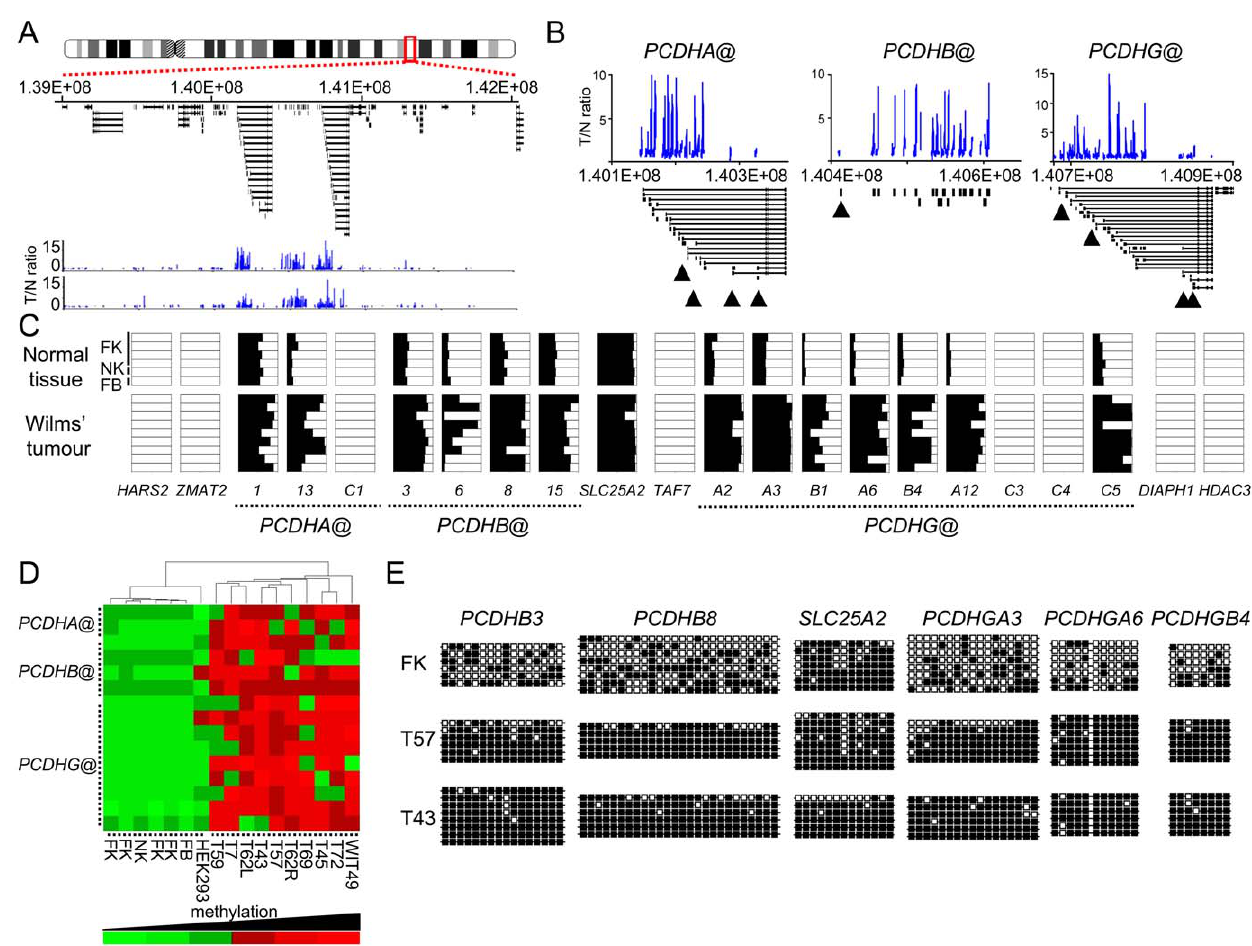
Figure 1. A large hypermethylated domain on chromosome 5q31 in Wilms’ tumour. (A) The MeDIP-chip tumour/normal (T/N) signal ratio shown for 2 representative WTs identifies hypermethylation of multiple gene promoters across a domain spanning 800 kb on chromosome 5q31.3 (red box). (B) The MeDIP-chip profile of PCDHA@ , PCDHB@ and PCDHG@ in a representative WT. A minority of genes escaping hypermethylation are indicated (black arrowheads). (C) DNA methylation assayed using COBRA. Percentage methylation was analysed by gel densitometry for each gene, and is represented by horizontal bars (black = percentage methylated, white = percentage unmethylated). Data from 6 normal tissues (4 fetal kidneys [FK], postnatal kidney [NK] and fetal brain [FB]) and 9 Wilms’ tumours are shown. Non- PCDH genes flanking the domain and between PCDHB@ and PCDHG@ are also shown. (D) Unsupervised hierarchical clustering of COBRA methylation data from normal and tumour tissues (T), HEK293 and WiT49 cell lines. (E) Bisulfite sequencing of PCDHB3 , PCDHB8 , SLC25A2 , PCDHGA3 , PCDHGA6 and PCDHGB4 5 9 CGIs in normal fetal kidney (FK) and 2 Wilms’ tumours, T43 & T57.